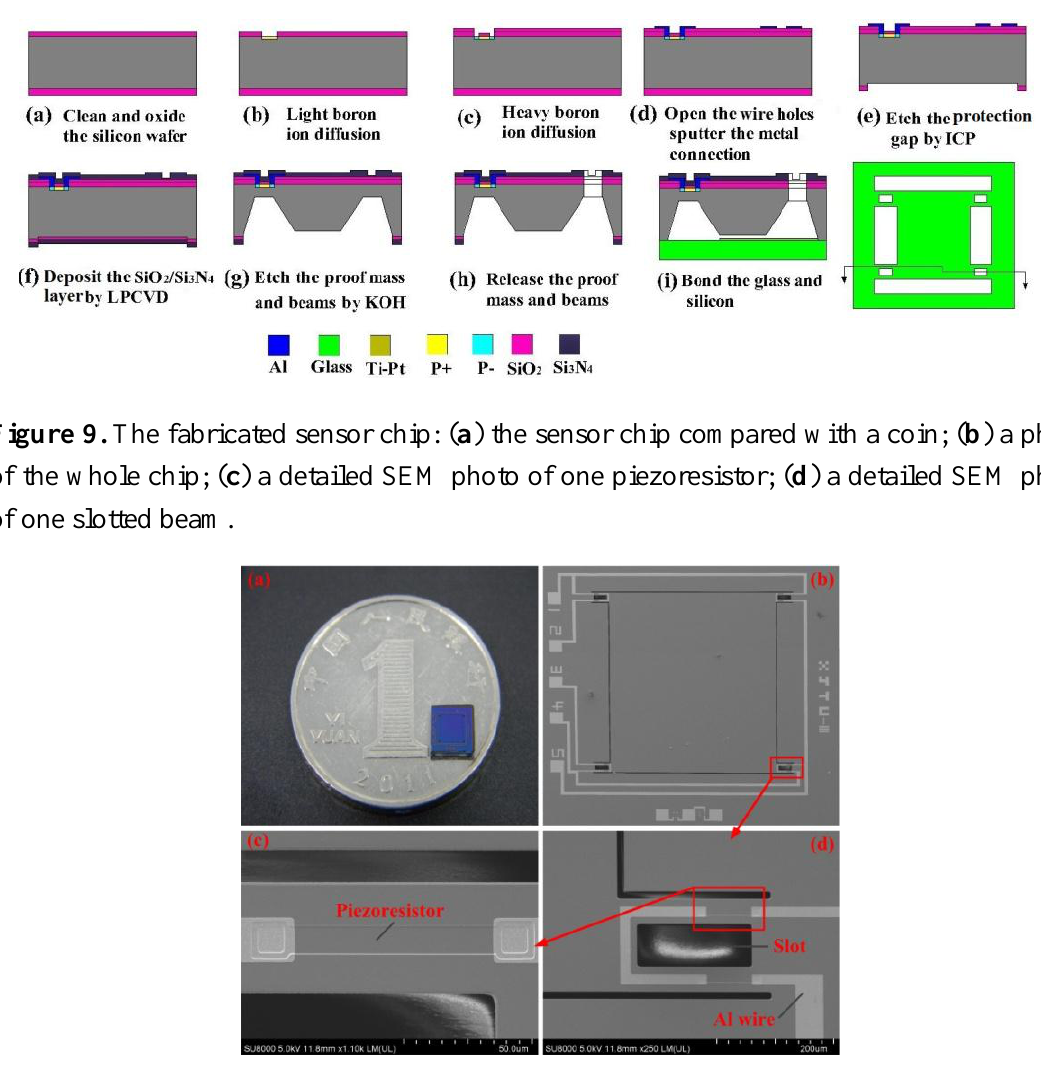
Figure 8. Main fabrication process of the sensor chip.